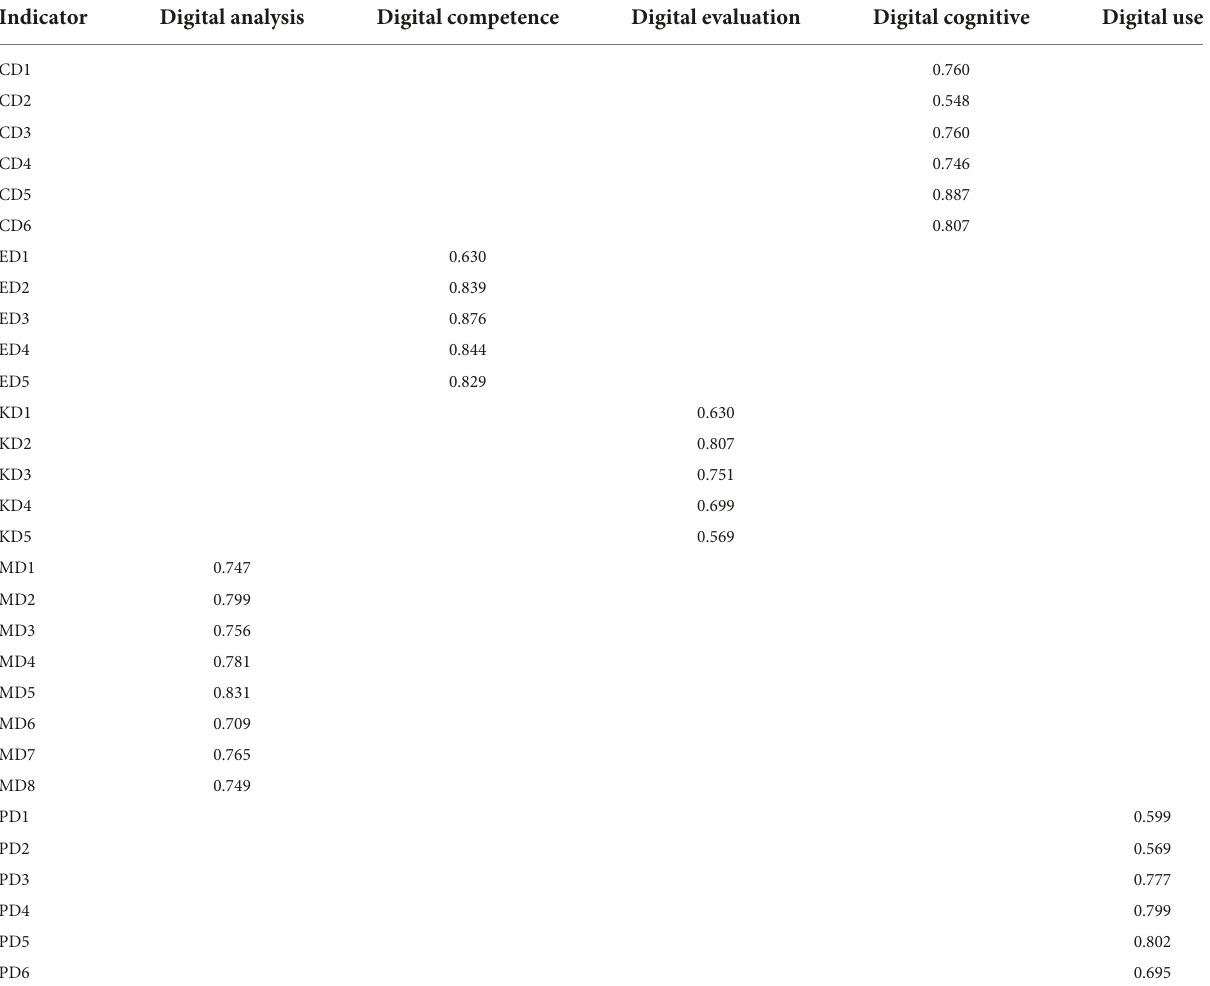
TABLE 1 Loading factor test of teachers’ digital pedagogical